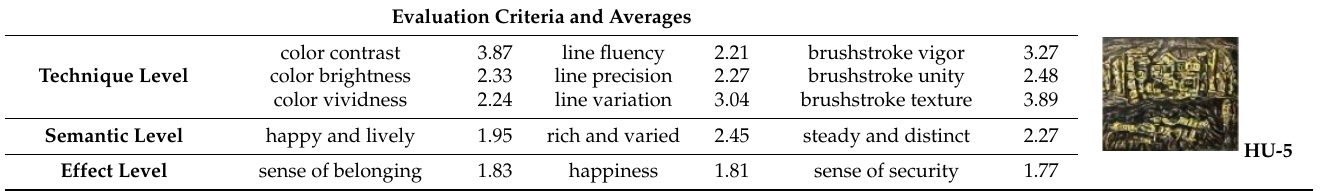
Table 3. Average for affective impact on the theme of Home Sweet Home for the human. Evaluation Criteria and Averages